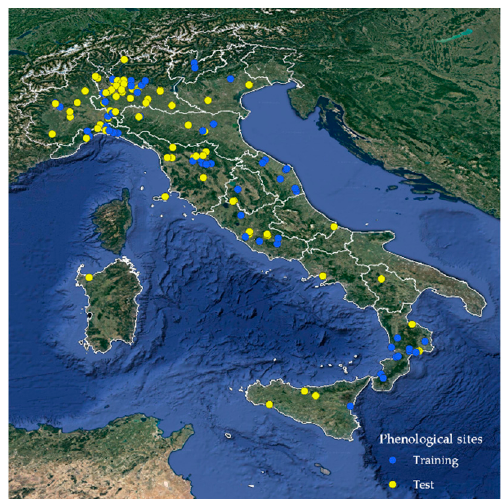
Figure 1. Calibration ( training) and validation (test) sites for the phenological model.